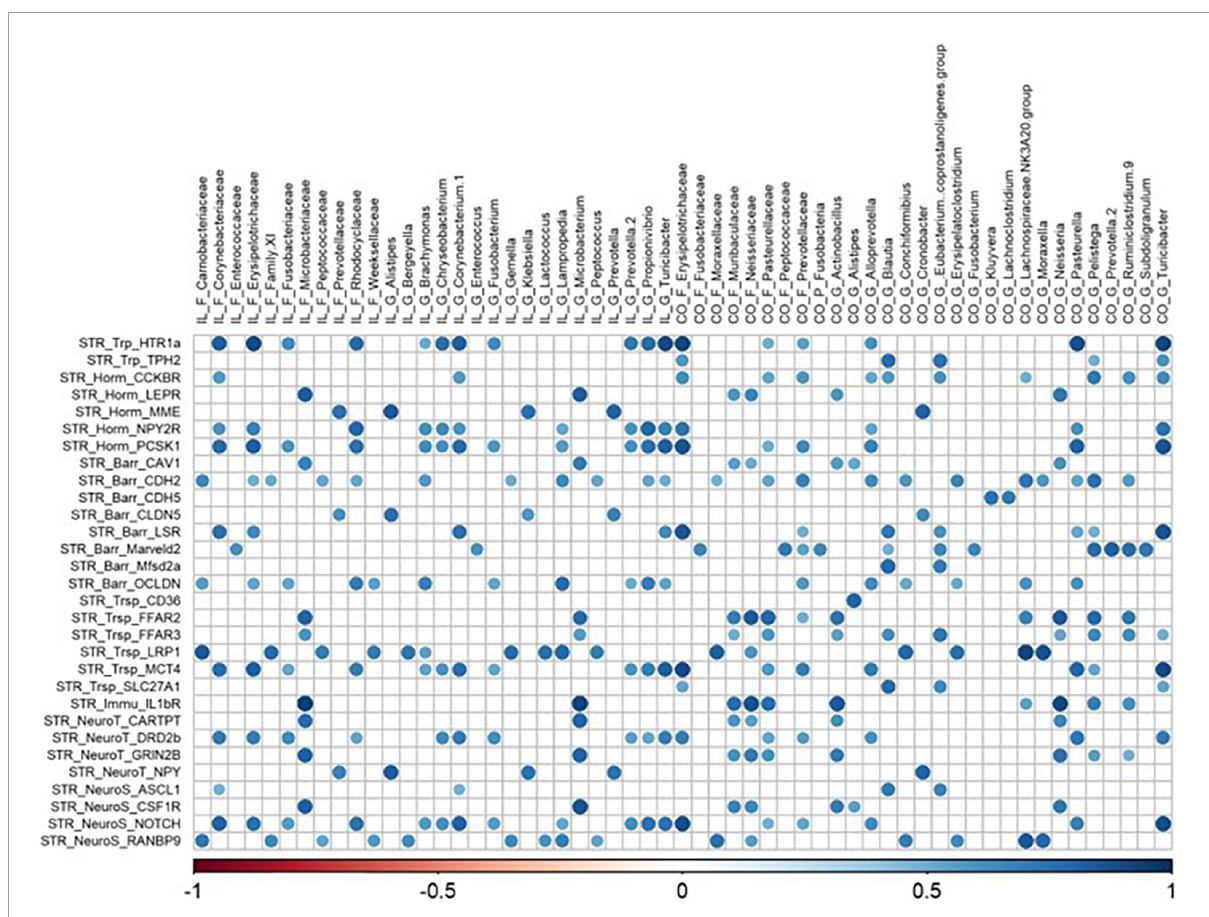
FIGURE6 Correlations matrix between striatal relative gene expression and ileal and colonic microbiota (| r | ≥ 0.7, P < 0.05). IL, ileum; CO, colon; F, family; P, phylum; G, genera; STR, striatum; Trp, tryptophan pathways; Horm, endocrine function; Barr, barrier function; Trsp, transport-nutrient carrier; Immu, immune function; NeuroT, neurotransmitters; NeuroS,